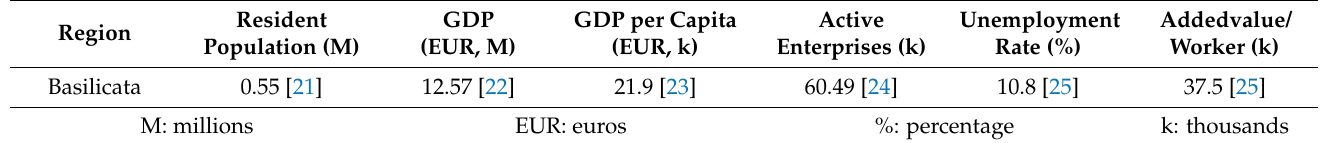
Table 1. Main socio-economic characteristics of the Basilicata region for the year